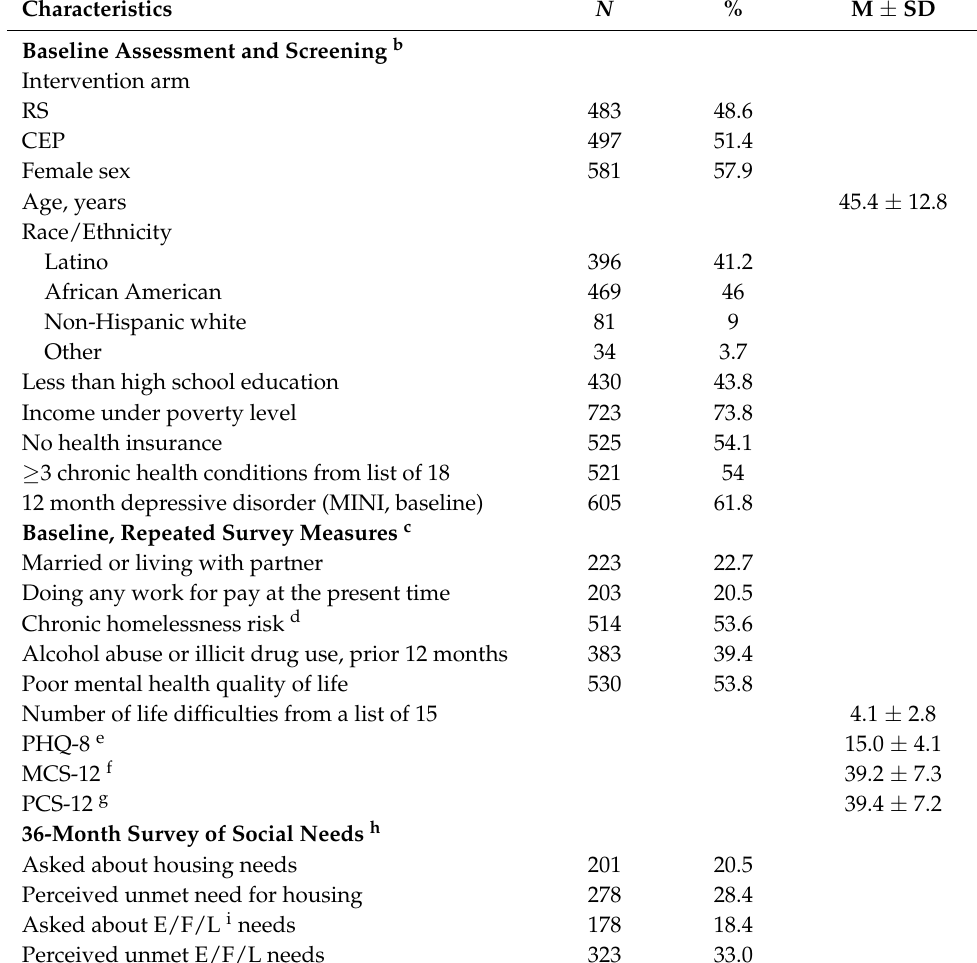
Table 1. Baseline Characteristics (and for social needs, 36-month survey) for Analytic Sample (Imputed) for 36 month follow-up for Community Partners in Care ( N = 980) a